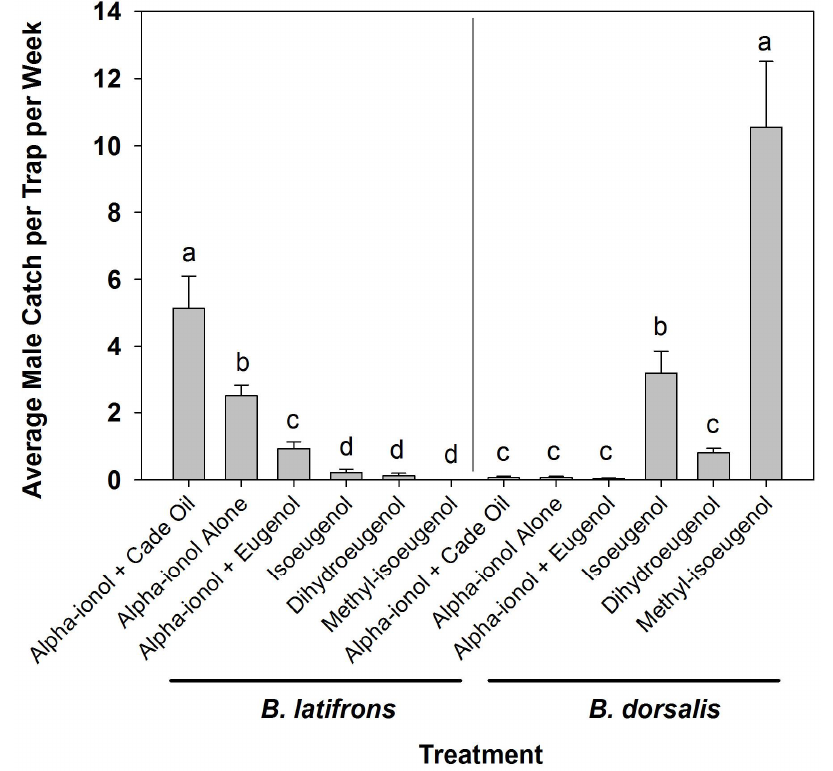
Figure 1. Average male B. latifrons catch (left) and B. dorsalis catch (right) per trap per week by treatment. Columns with the same letters are not significantly different at the α = 0.05 level. Analysis of variance (ANOVA) was run separately for B. latifrons and B. dorsalis catches.